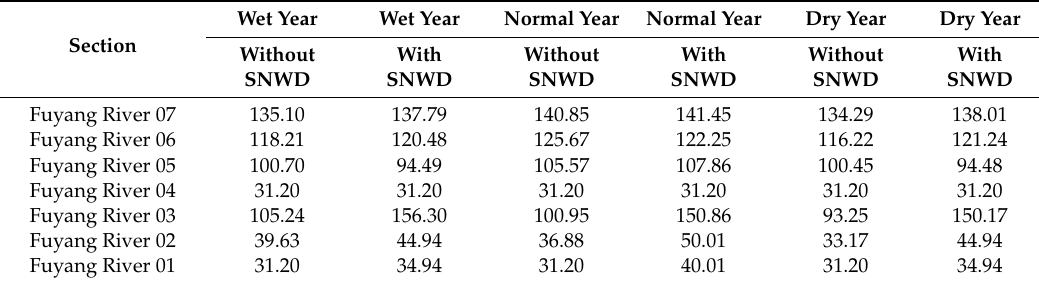
Table 3. Yearly runo ff of di ff erent sections of the Fuyang River (Unit 10 6 m 3